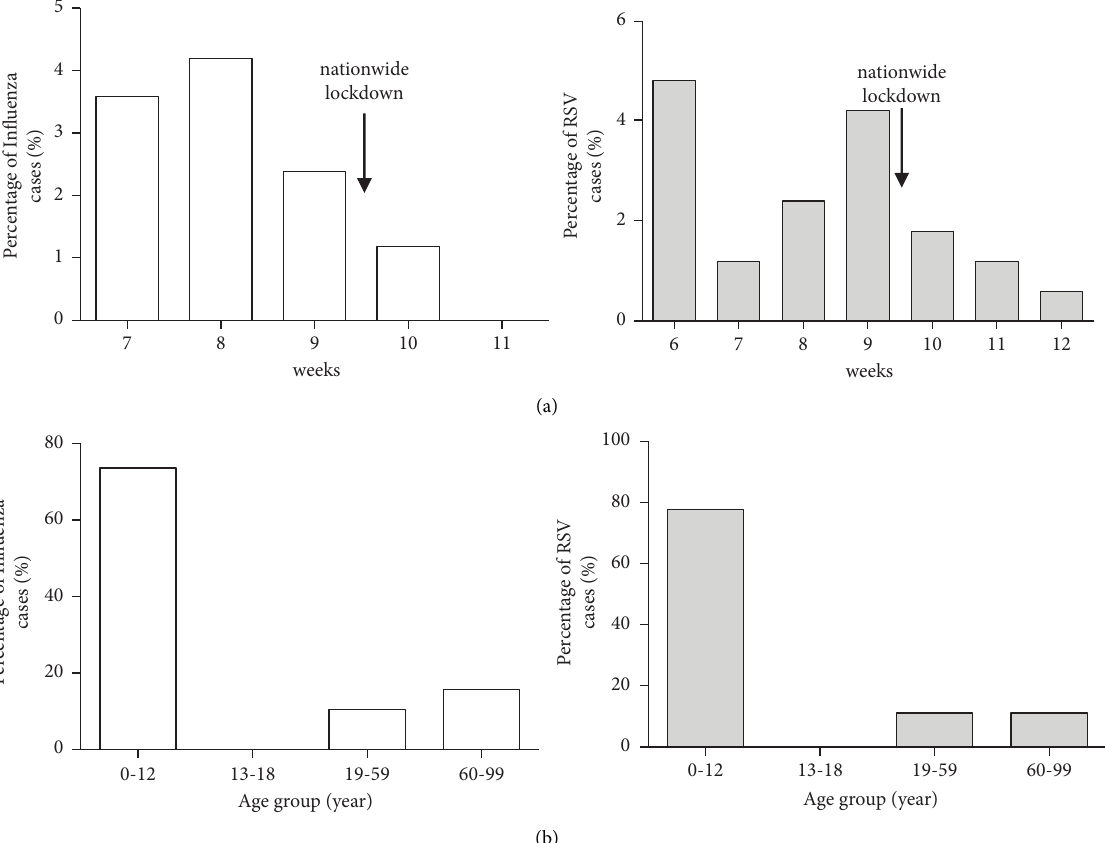
Figure 1: (a) Laboratory-detected cases of infuenza A/B and RSV during the 2019/2020 season at our center. Vertical bars show percentage of INF-A/B and RSV positive specimens identifed by week 6–7/2020 to 11–12/2020 (b) Distribution of INF-A/B and RSV cases during 2019/ 2020 season according to age